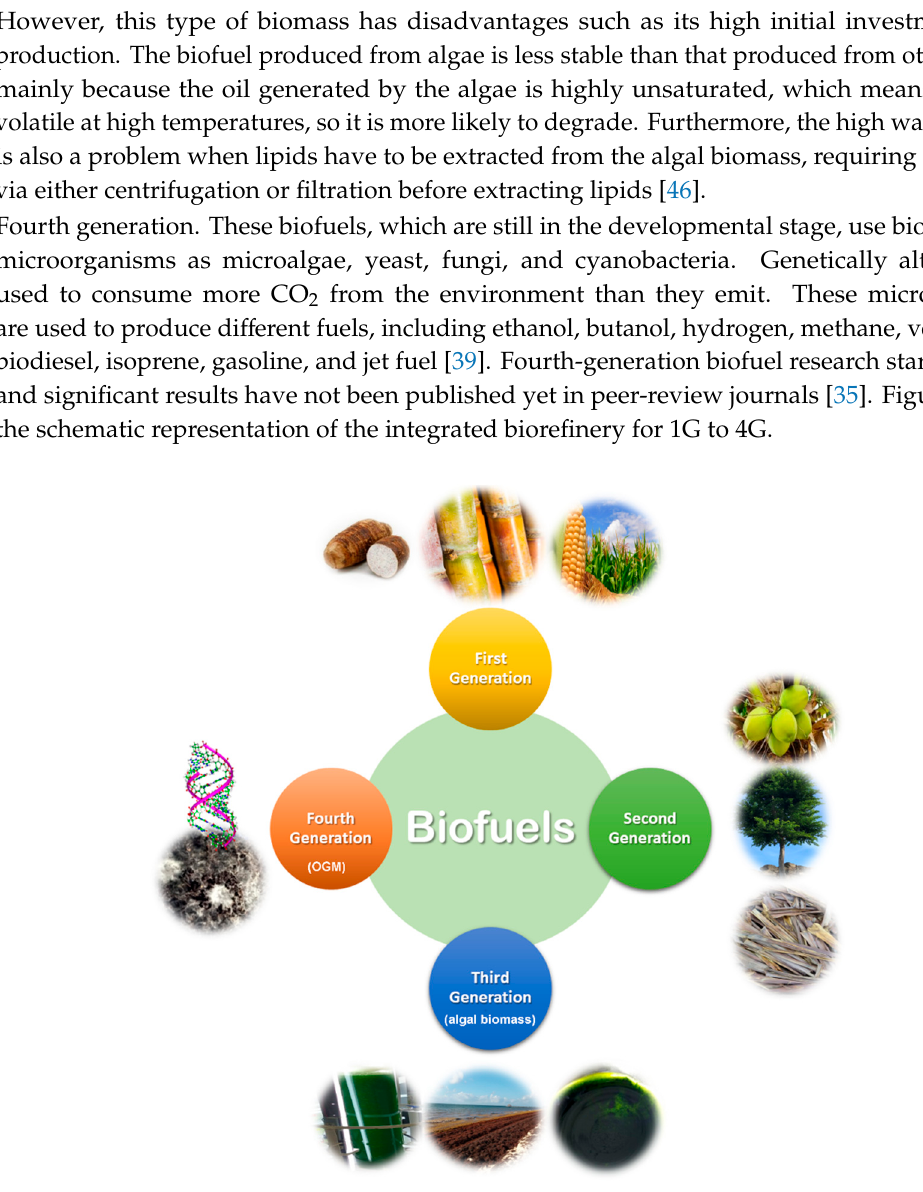
Figure 1. Schematic representation of integrated biorefinery for first, second, third, and fourth generation of biomass.